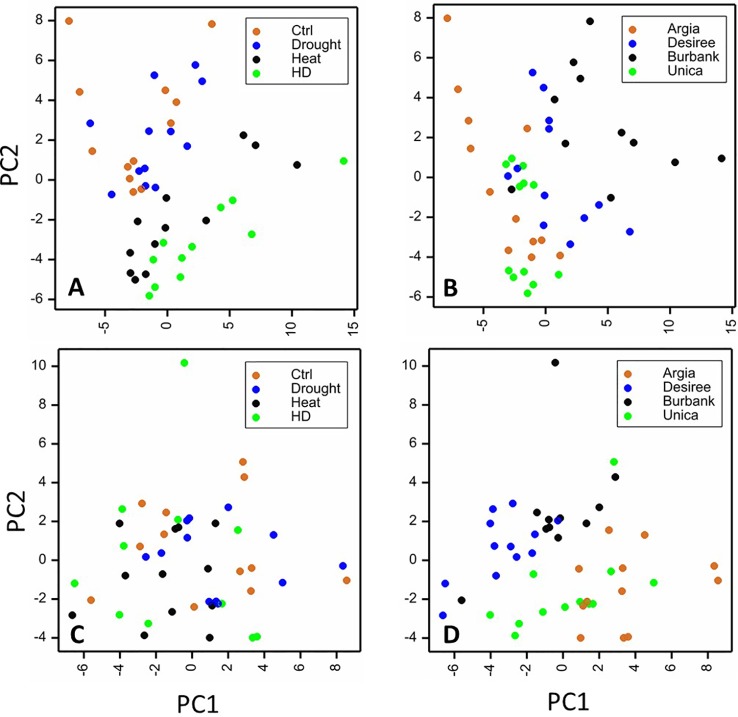
Principal components analysis (PCA) plots of leaf samples based on metabolite profiles. Sample replicates are plotted against principal components (PC) 1 and 2 based on their content of polar (A, B) or non-polar (C, D) metabolites. Samples are labeled according to treatment (A, C) or genotype (B, D). For polar compounds PCs 1 and 2 represented 27 and 18% of the variance, respectively and for non-polar compounds PC1 represented 30% of the variability while PC2 represented 20%.